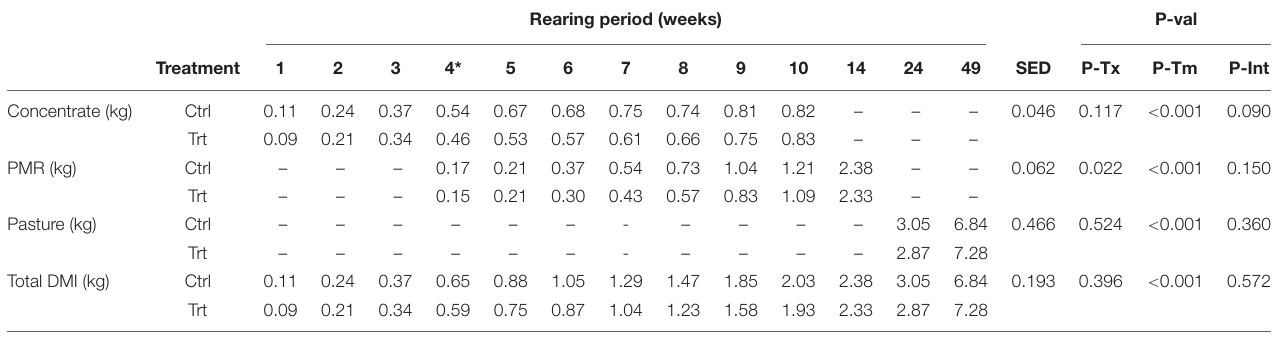
TABLE 3 | Effect of methane inhibitors 1 on dry matter intake (DMI).